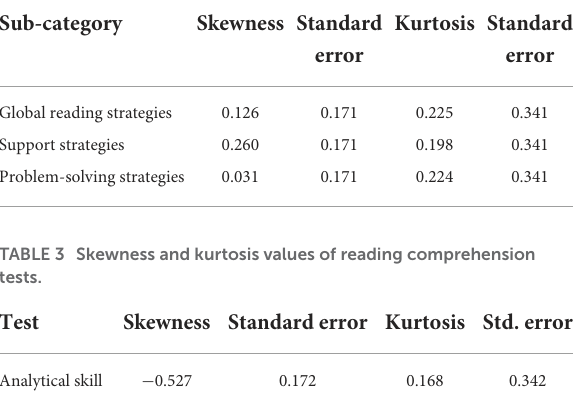
TABLE 2 Skewness and kurtosis values of Survey of Reading Strategies.